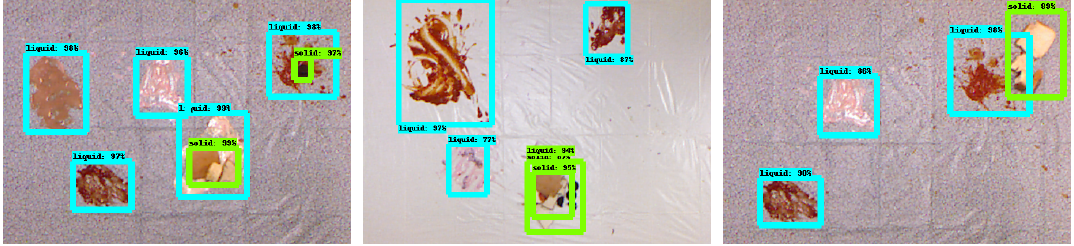
Figure 6. Detection of mixed